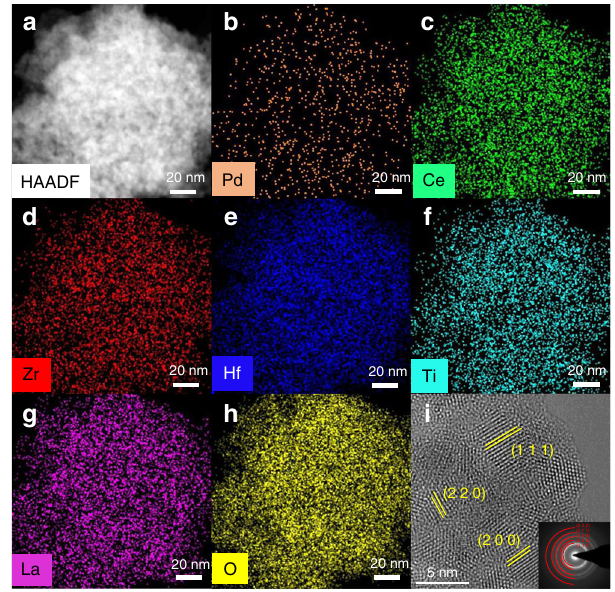
Fig. 3 Microscopic characterizations of Pd 1 @HEFO. a EDS-mapping image of b Pd, c Ce, d Zr, e Hf, f Ti, g La, and h O for Pd 1 @HEFO; i HRTEM image and corresponding FFT pattern (inset) of Pd 1